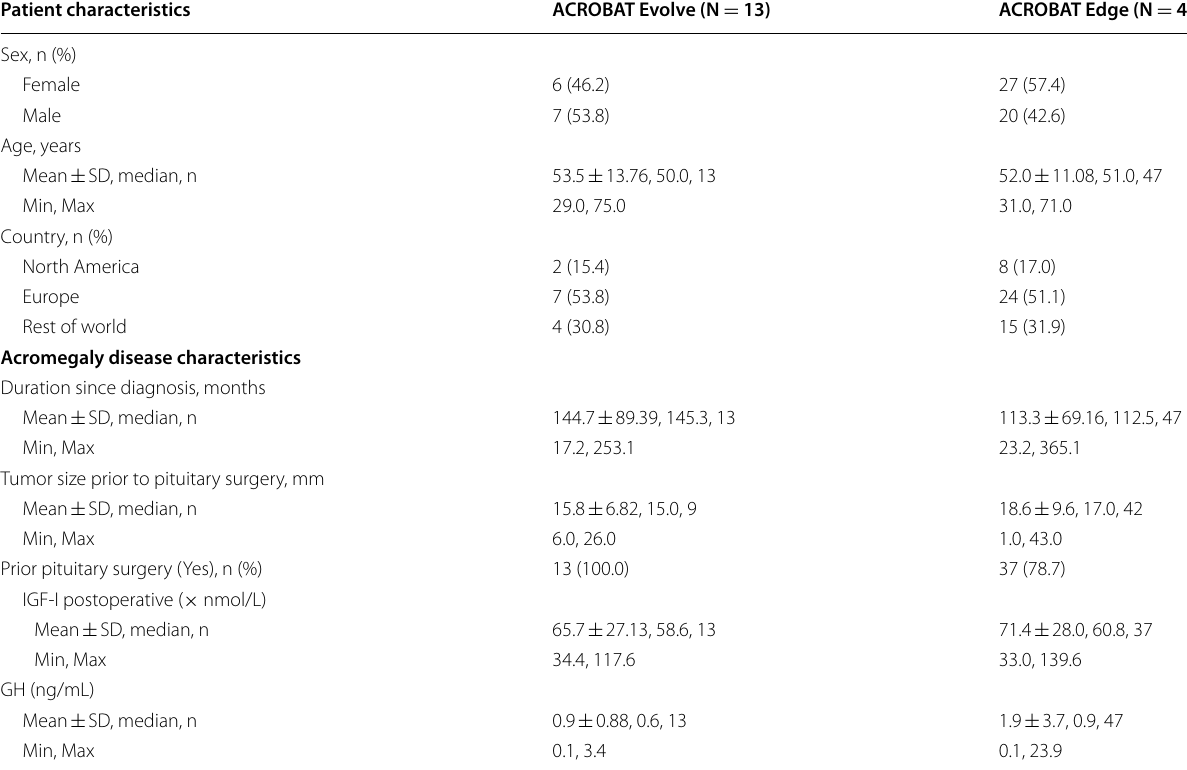
ASD Acromegaly Symptom Diary; GH =